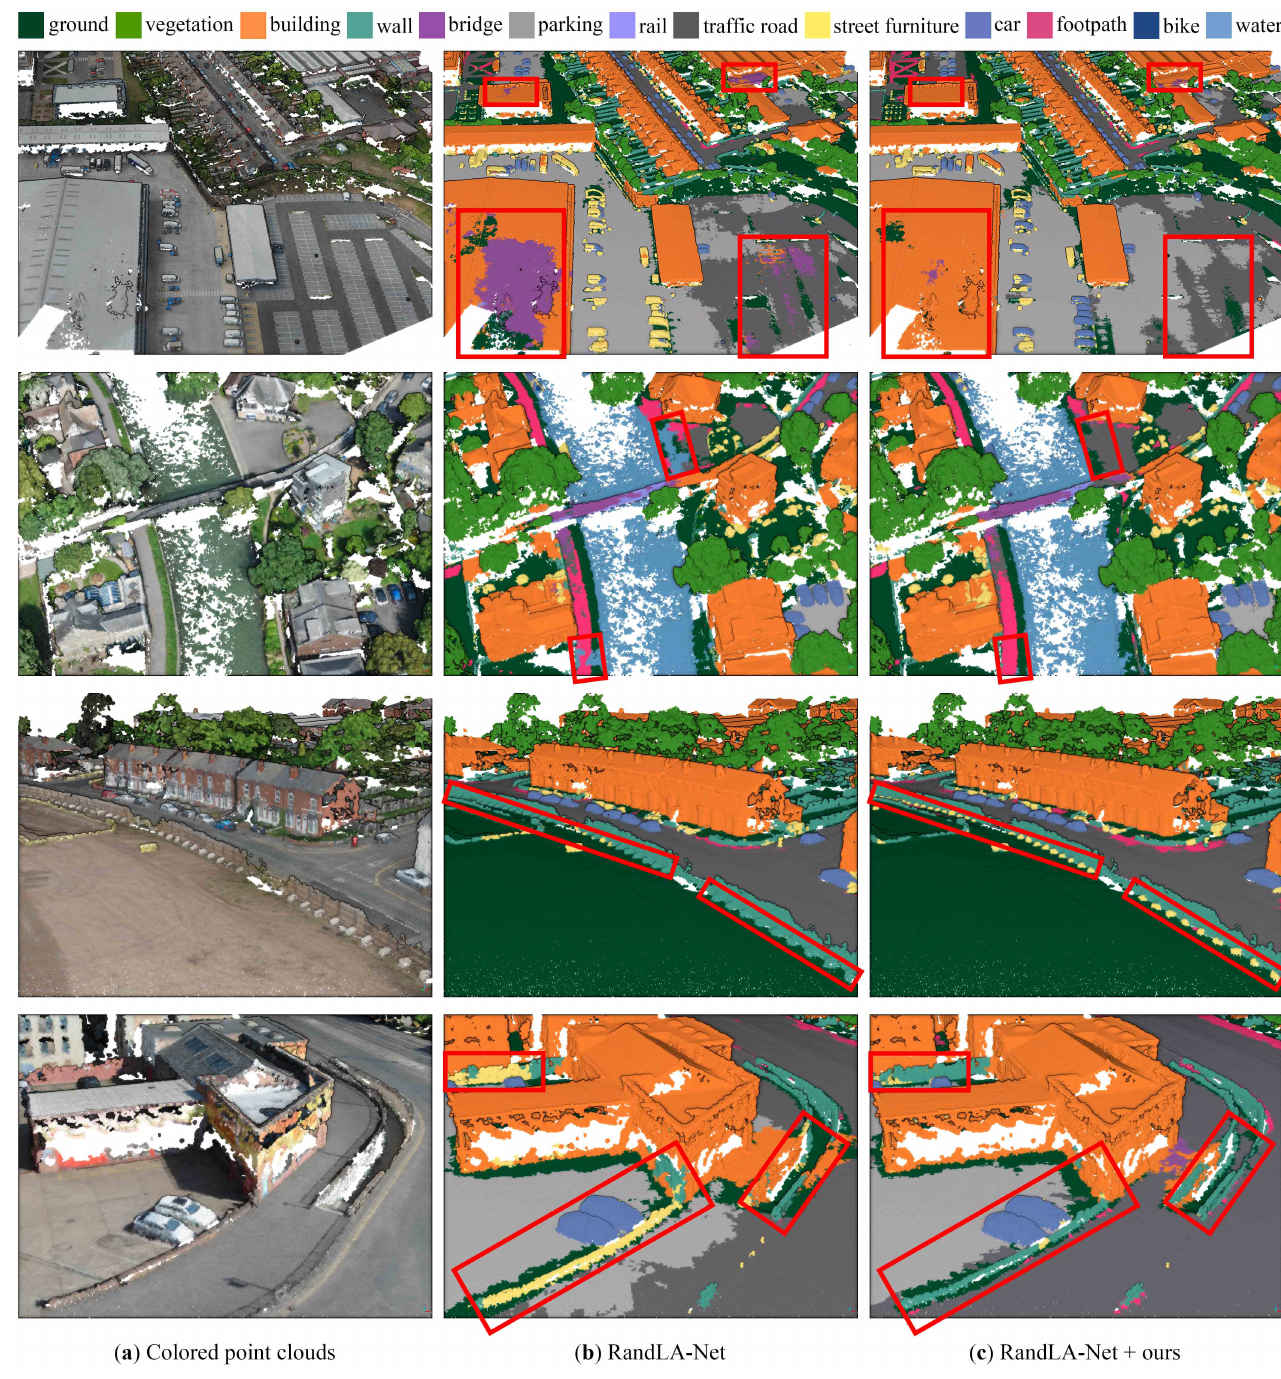
Figure 6. Visual comparison of semantic segmentation results on the SensatUrban dataset [25]. The red rectangles highlight the major differences in the results between the baseline method and ours. Table 6. Quantitative comparison of semantic segmentation results on the SensatUrban dataset